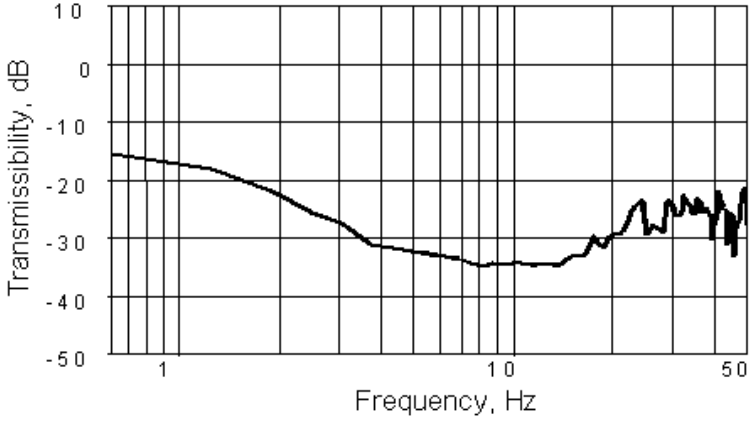
Fig. 7. Experimental transmissibility of the active vibration isolation system in the vertical direction.